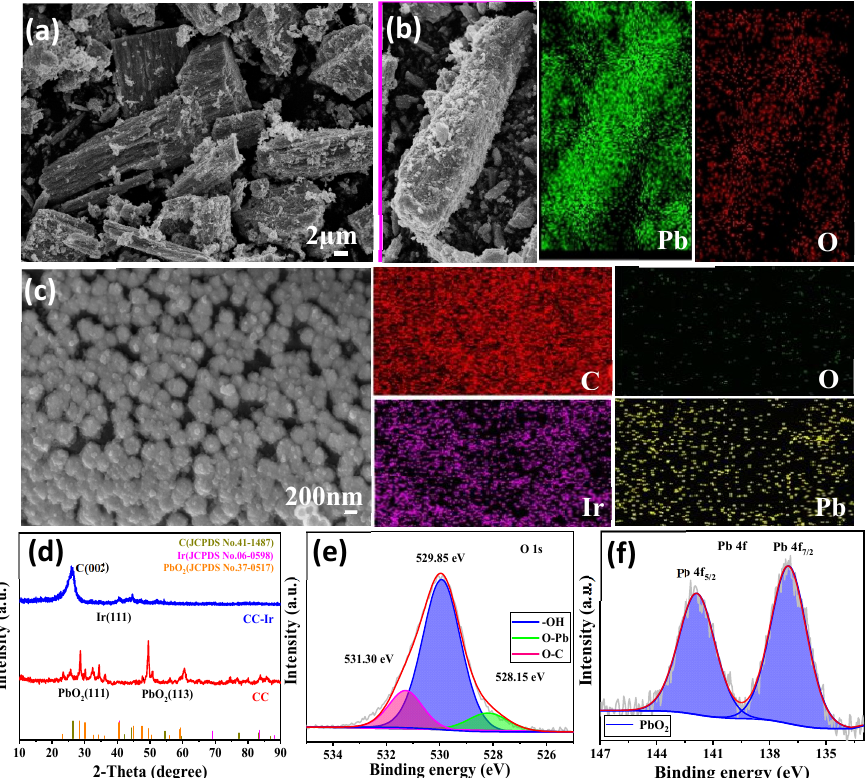
Figure 6. ( a ) SEM image and ( b ) mapping image of the anode product after electrolysis with CC catalyst, and ( c ) with CC-Ir. ( d ) XRD patterns of products with CC, or CC-Ir. ( e , f ) High-resolution O 1s and Pb 4f XPS spectra of production after CC-Ir electrolysis, respectively.